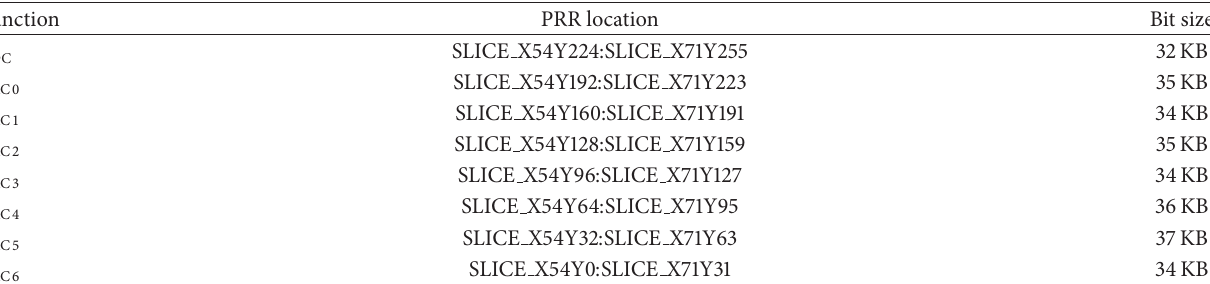
Figure 15: A comparison of DRFI with TMR in terms of system’s capability to sustain multiple failures. Table 3: Configuration bitstreams storage requirement for DCT